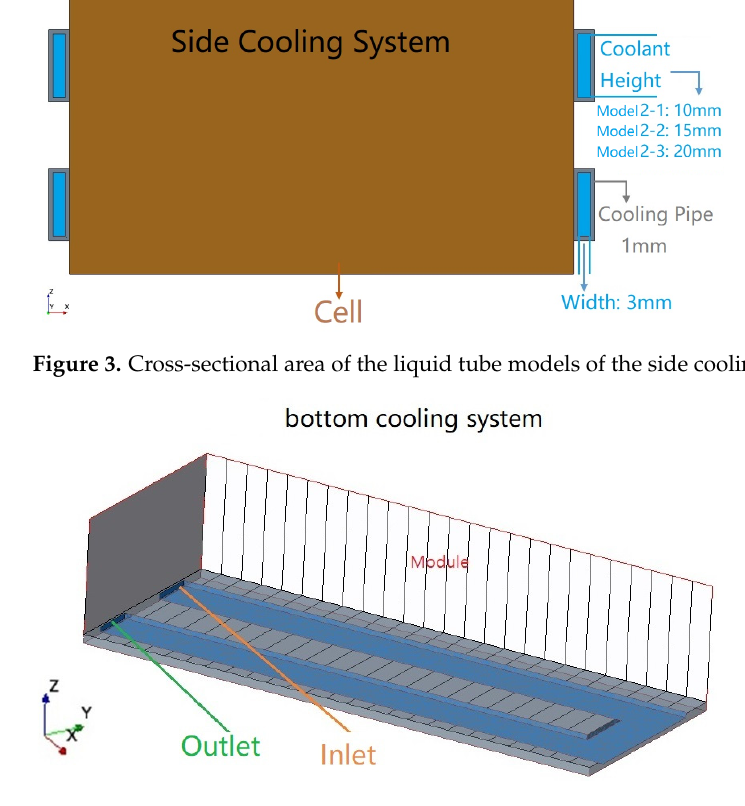
Figure 5. Perspective view of the coolant flow path created in the battery module for the side cooling system. 4.2. Numerical Scheme In this numerical study, CATIA was used to shape the models, ANSA was used to generate the surface grids of the models, and STAR CCM+ (ver. 2016) was used to evaluate the cooling performance of the model cooling system from the numerical simulation re- sults. All these software are general-purpose 3-D modeling programs. For the numerical study, the cartesian coordinate system is shown in Figures 4 and 5 [5], and all six full-scale models were analyzed with the same practical initial and bound- ary conditions to make sure every case was in the same thermal situation. The detailed setting is as shown below. 4.2.1. Grid Generation For discretization of the domain, the CAD-to-CFD method was used for grid gener- ation in the numerical domain. After the models were made by CATIA V5 (Dassault Sys- tèmes, Vélizy-Villacoublay, France), the surface grids of the models were generated by